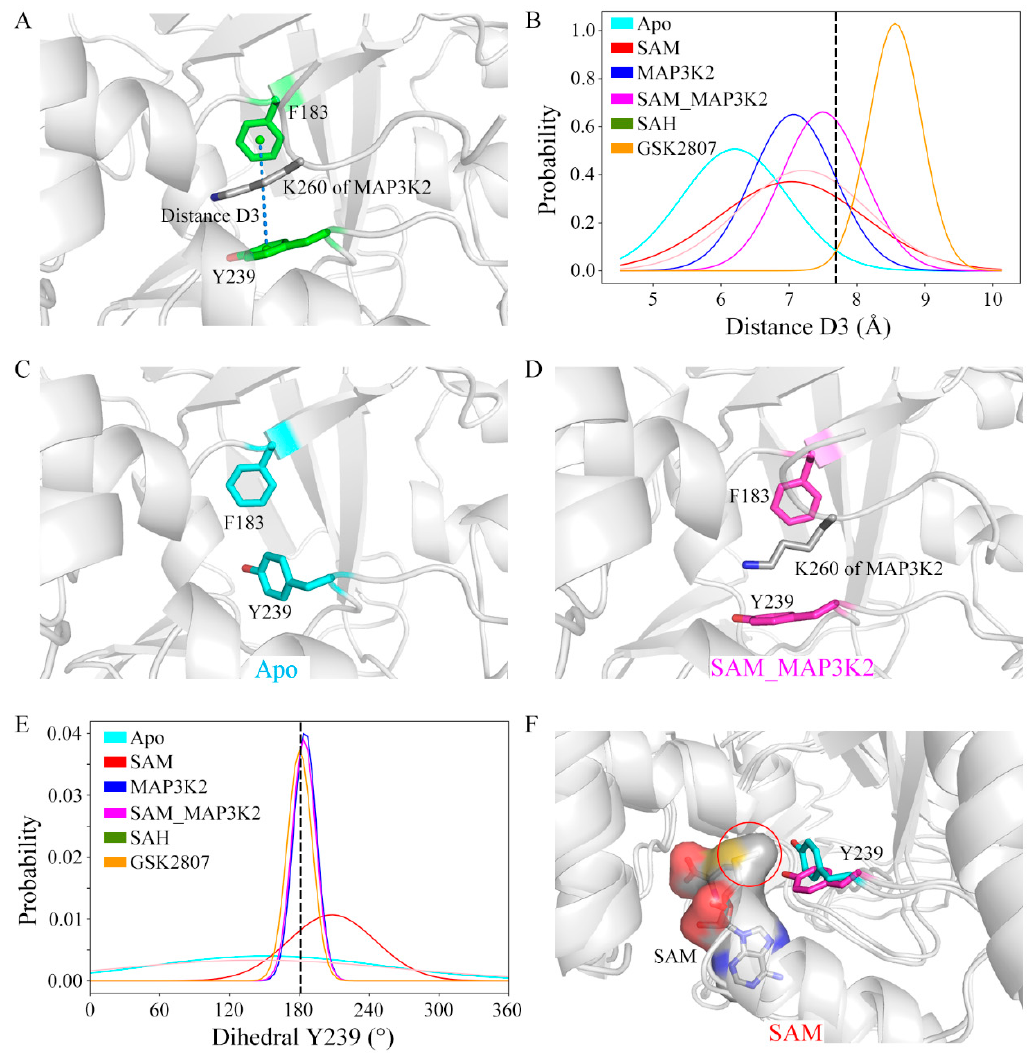
Figure 5. Structural details of the lysine-binding channel. ( A ) Definition of distance D3 in the structure of SMYD3. Residues in SMYD3 and the MAP3K2 peptide are shown as green and grey sticks, respectively. ( B ) Distributions of distance D3. The initial value in the crystal structure is labeled using a black dash. Conformational state of Y239 in the representative structures of the ( C ) Apo (cyan) and ( D ) SAM_MAP3K2 (magenta) systems. ( E ) Distributions of dihedral Y239. The initial value in the crystal structure is labeled using a black dash. ( F ) Two different conformational states of Y239 in the SAM system. Y239 in the initial and flipped conformational states are shown as magenta and cyan sticks, respectively. SAM is shown as grey sticks and with a grey